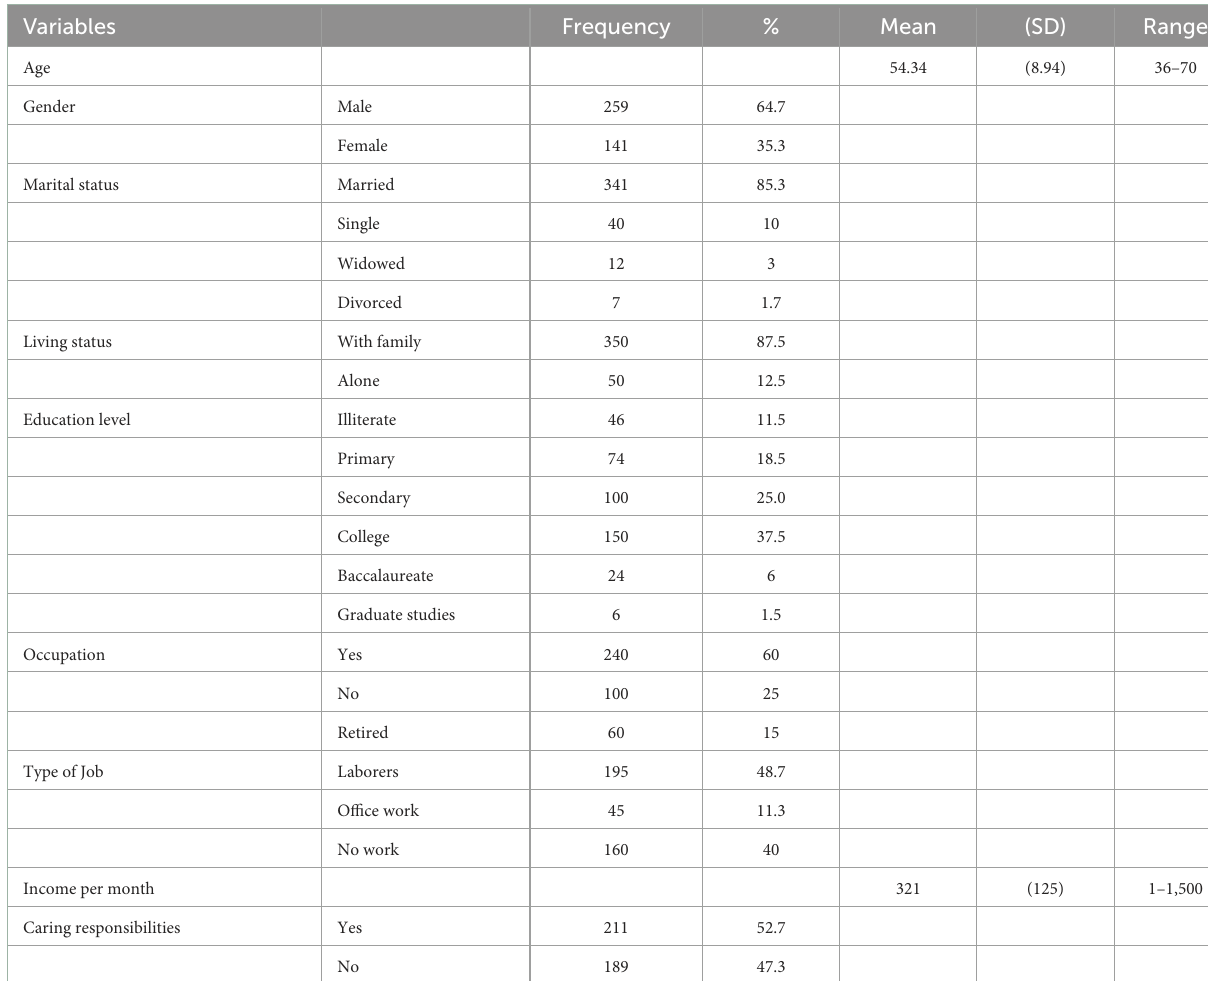
TABLE 1 Sociodemographic characteristics of the sample ( n = 400).